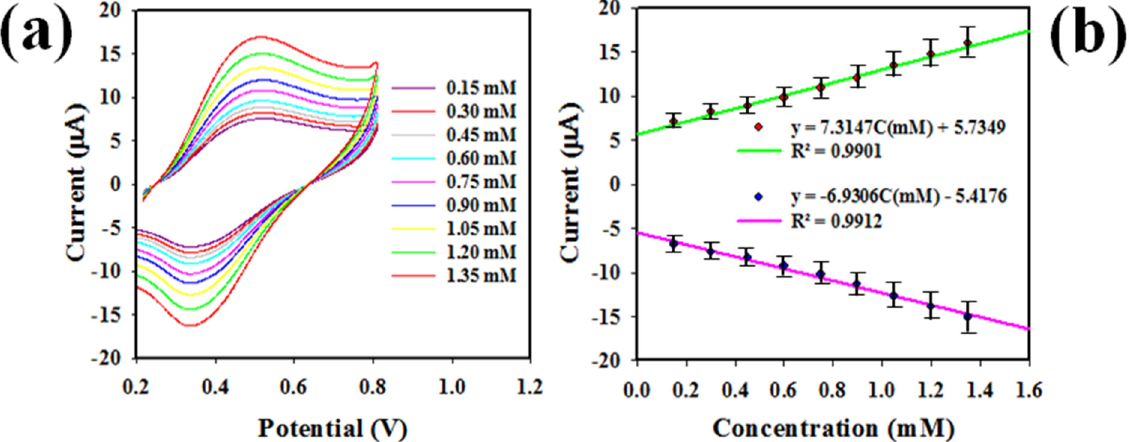
Figure 7. ( a ) The SR of modified GCE in electrochemically analysis of 0.6 mM UA, in pH = 7.0 buffer solution, ( b ) the square -root of SR versus oxidation-reduction peak point currents of UA.